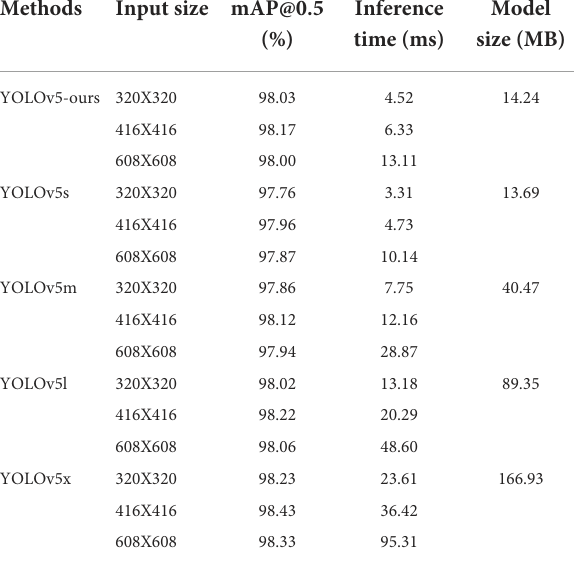
TABLE 1 Performance on leaf location testing set for each object detection method. Methods